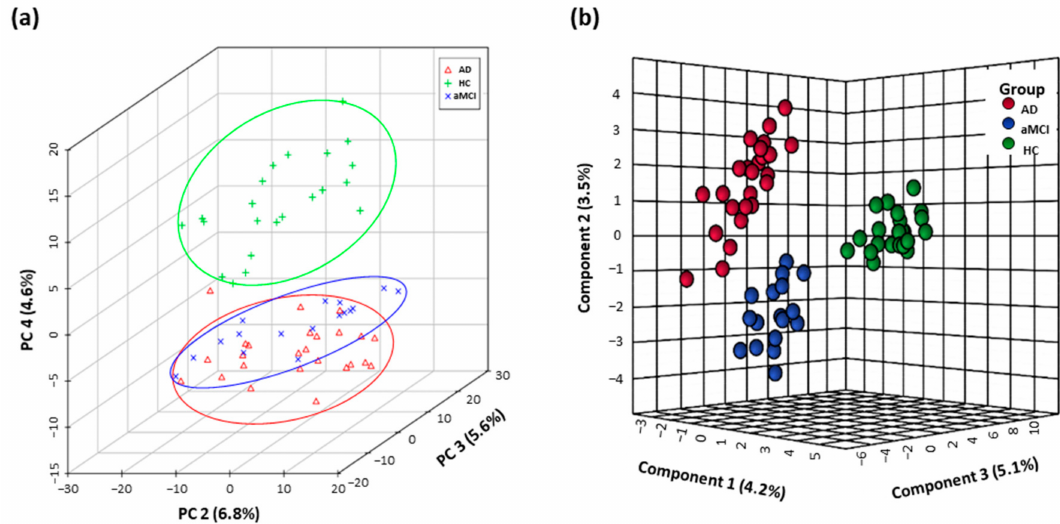
Figure 1. Fecal metabolomics profiles separated AD patients from HC. Differential fecal metabolomics profiles among aMCI (n = 17), AD (n = 25) and HC (n = 22) were presented by ( a ) PCA score plot based on untargeted high-throughput UHPLC-orbitrap Q Exactive-MS metabolic profiling and ( b ) PLS-DA model based on top twenty-five differential metabolites. Abbreviations: HC, normal cognition healthy control; aMCI, amnestic mild cognitive impairment; AD, Alzheimer’s disease; PCA, principle component analysis; PLS-DA, partial least-squares-latent structure discriminate analysis; UHPLC, ultra-high performance liquid chromatography; MS, mass